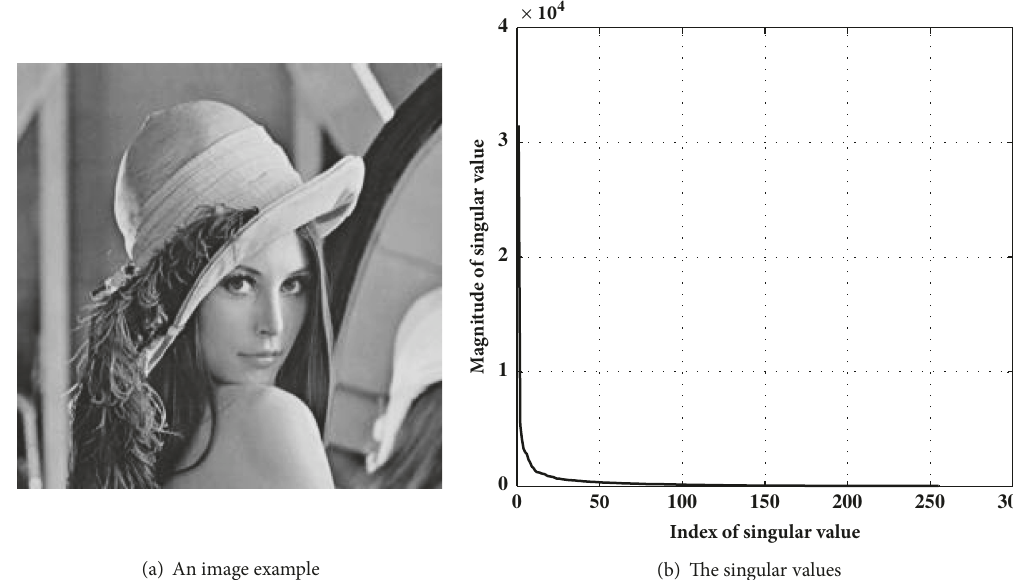
Figure 1: (a) Lenna image ( 256 × 256 ). (b) All the singular values of Lenna image are sorted from larger to smaller. A simple calculation will lead to the fact that the top 40 singular values contribute more than 80% information of all singular values.